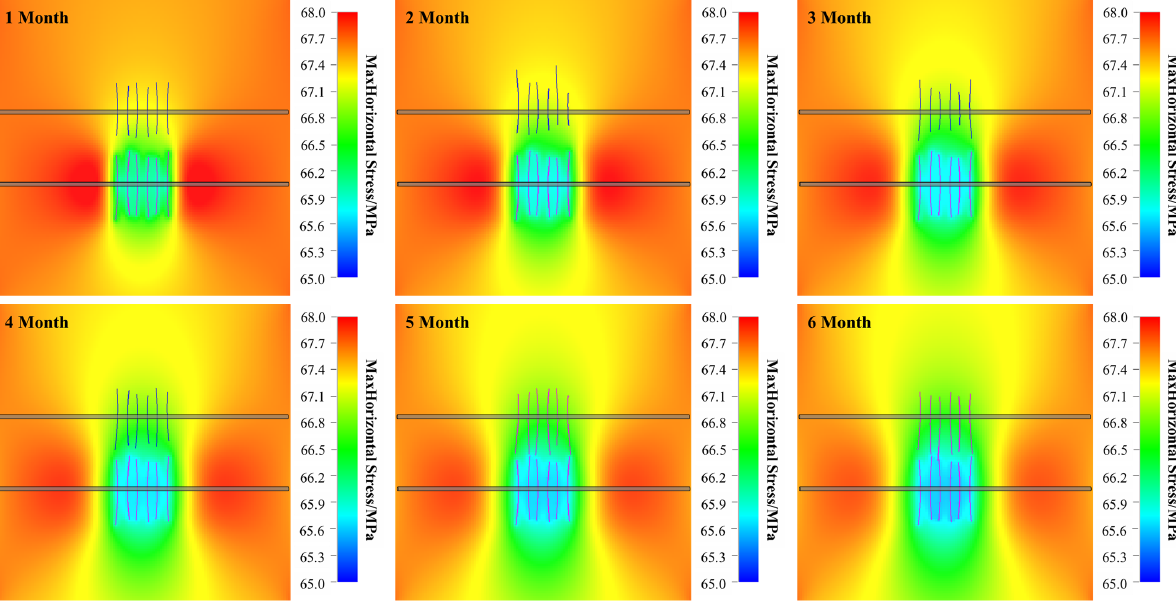
Figure 13. Maximum horizontal in-situ stress distribution and fracture morphology at different production times under the influence of pressure depletion.